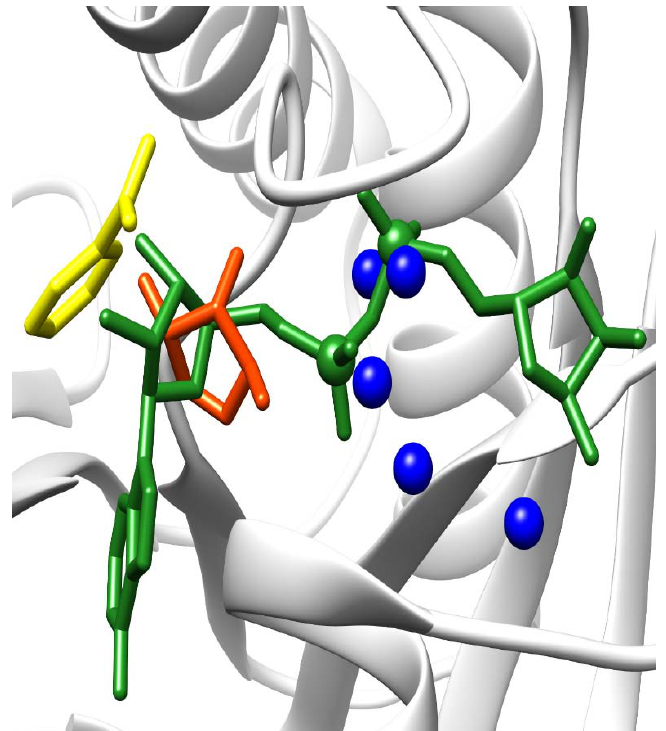
Figure 7. ADP ‐ ribose binding site. The ADP ‐ ribose molecule bound by macroH2A1.1 (PDB Figure 7. ADP-ribose binding site. The ADP-ribose molecule bound by macroH2A1.1 (PDB structure structure 3iid, colored in green) has been rototranslated onto the apo ‐ form of macroH2A1.1 (PDB 3iid, colored in green) has been rototranslated onto the apo-form of macroH2A1.1 (PDB structure structure 1zr3, colored in white) after structural alignment. The nucleotide ‐ binding site predicted 1zr3, colored in white) after structural alignment. The nucleotide-binding site predicted by Nucleos by Nucleos is composed of one nucleobase ‐ binding site (colored in yellow), a carbohydrate ‐ is composed of one nucleobase-binding site (colored in yellow), a carbohydrate-binding site (colored binding site (colored in orange), and several putative phosphate ‐ binding sites (colored in blue). in orange), and several putative phosphate-binding sites (colored in